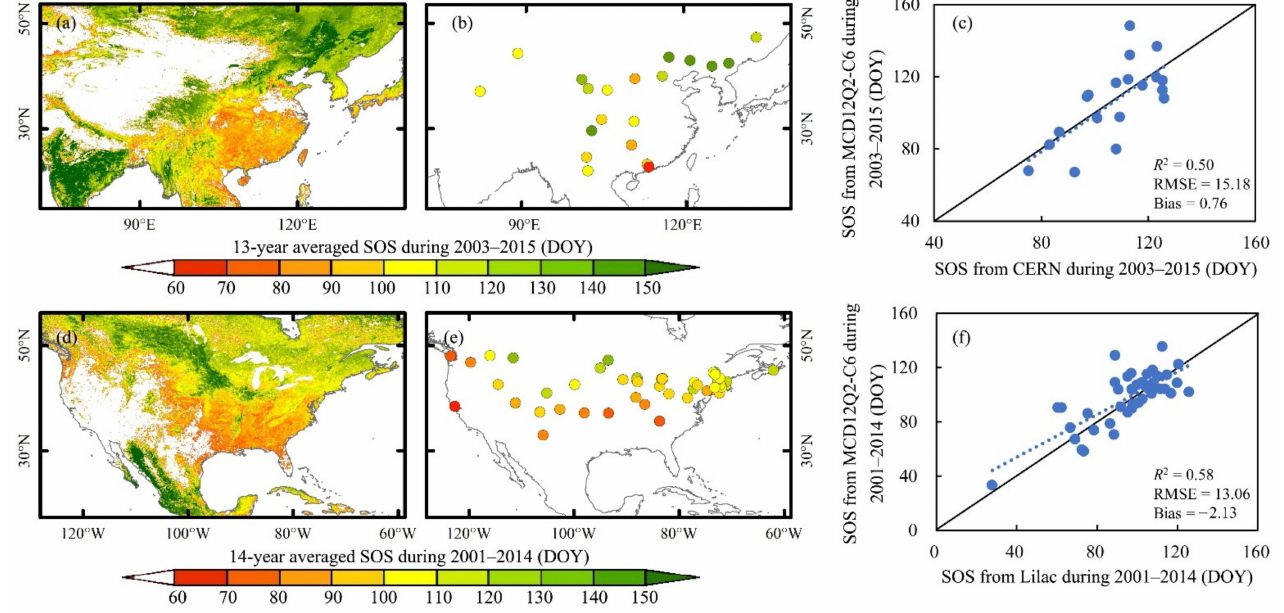
Figure 2. The 13-year averaged SOS from the ( a ) MCD12Q2-C6 and ( b ) CERN during 2003–2015. ( c ) Linear scatter plots between the SOS from the MCD12Q2-C6 and CERN during 2003–2015. Climatology of the 14-year averaged SOS calculated from the ( d ) MCD12Q2-C6 and ( e ) Lilac during 2001–2014. ( f ) Linear scatter plots between the SOS from the MCD12Q2-C6 and Lilac observations during